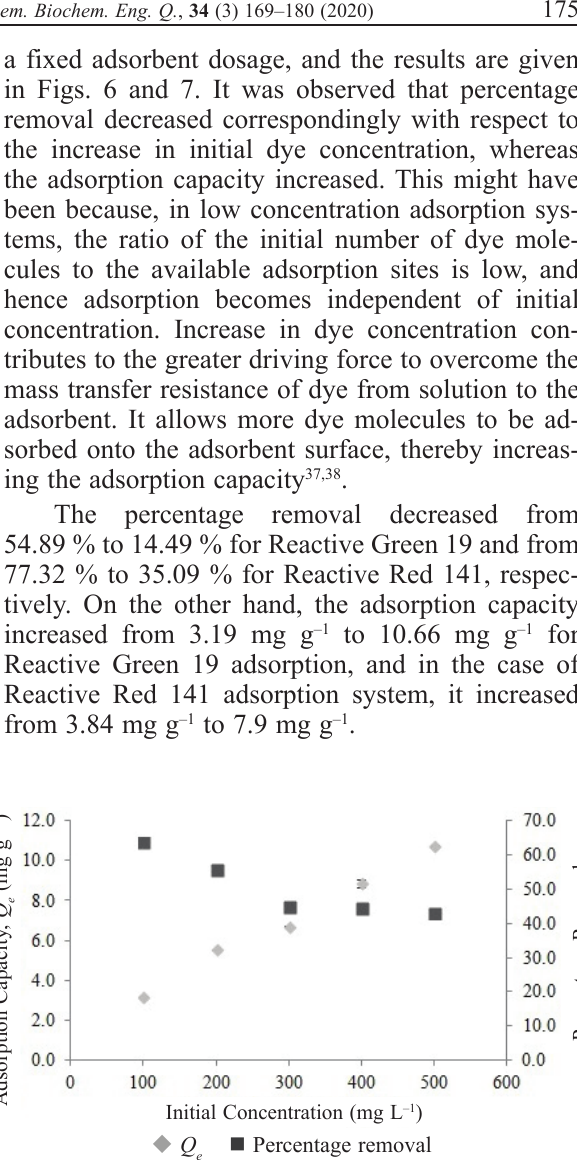
Fig. 6 – Effect of initial dye concentration on percentage re- moval and adsorption capacity for Reactive Green 19 adsorp- tion (adsorbent dosage = 1.0 g/50 mL; pH = 6; contact time = 220 min)